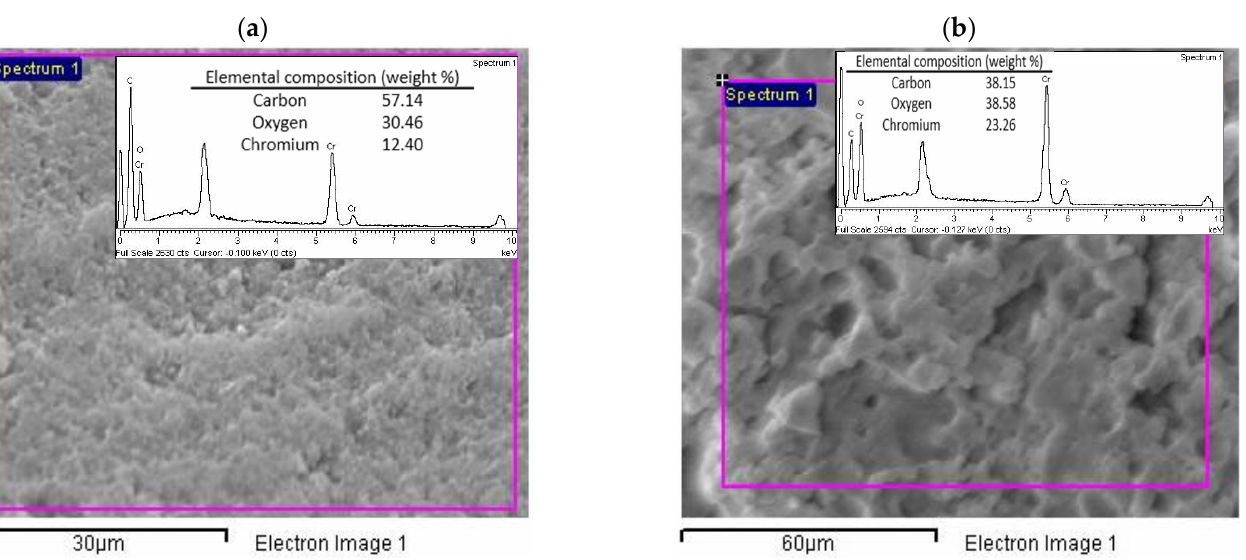
Figure 11. EDX spectra analysis of the eucalypt stump ( a ) and kraft lignin ( b ) after adsorption of Cr(VI) ions.